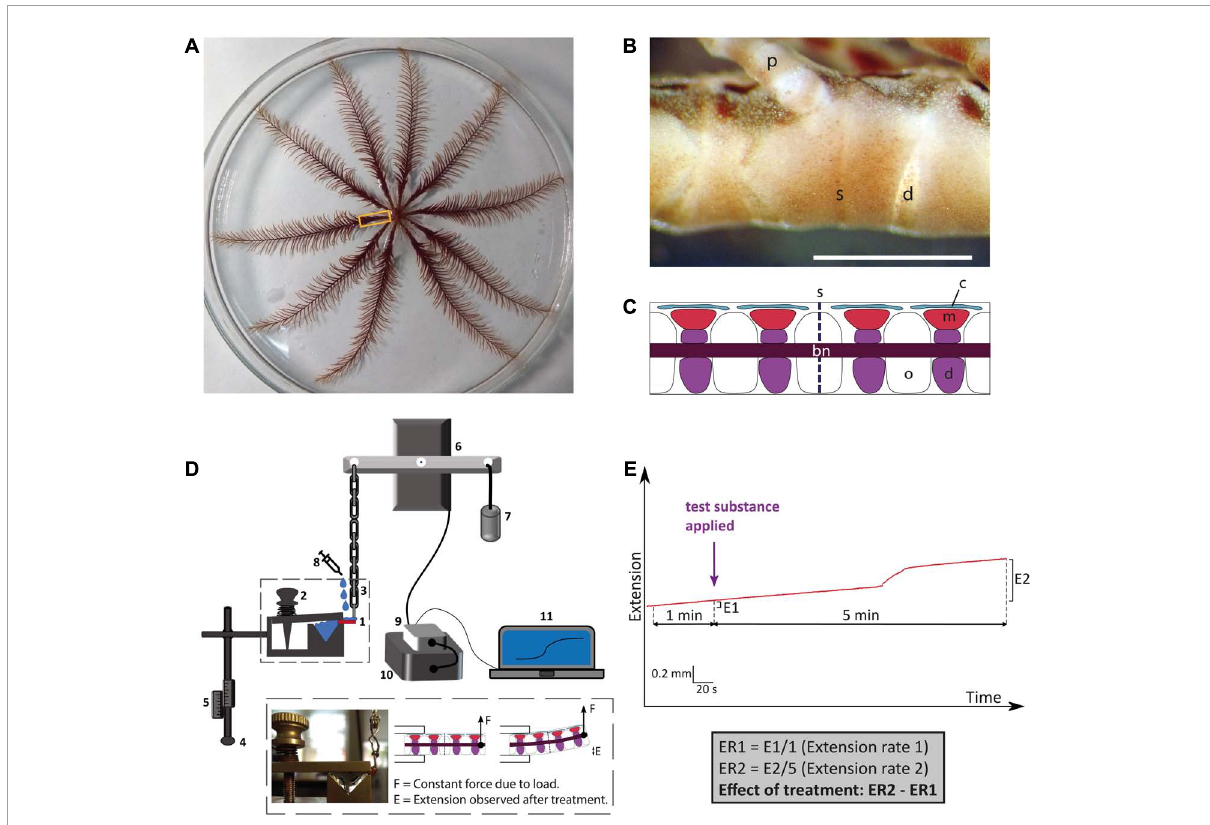
FIGURE1 Anatomy of the whole-body and arms of adult Antedon mediterranea and experimental set-up used to investigate effects of neuropeptides on the mechanical behavior of arm preparations. (A) Photograph of a whole adult specimen of A. mediterranea in an 18 cm diameter petri dish. The rectangle shows the region of an arm nearest to the calyx, which corresponds to the region from which experimental preparations were dissected. (B) Photograph of lateral view of an arm, oral side up and proximal end to the right. The scale bar is 1 mm. d, diarthrosis; s, syzygy; p, pinnule. (C) A schematic drawing of a sagittal section of an arm equivalent to the portion shown in panel (B) . Major anatomical structures are labeled as follows: bn, brachial nerve; c, coelom; d, diarthrosis; m, muscle; o, ossicle; s, syzygy. (D) Schematic drawing of the experimental set-up for testing the effects of neuropeptides on the mechanical properties of arm preparations. The arm preparation (1) is orientated with its oral side up, as is the natural position of the arm, and is clasped at its proximal end by a spring-loaded clamp (2) and connected at its distal end via a heart clip to a chain (3). The exact positioning of the arm preparation in relation to the apparatus can be regulated by a system of rods that are adjusted using clamp manipulators (4) and scales (5). The chain is connected to an isotonic lever transducer (6) and at the opposite end of the lever is a weight of 10 g (7), which creates a tension in the arm preparation similar to that in an arm outstretched for food collection in the animal’s natural environment (La Touche, 1978; Byrne and Fontaine, 1981). Test substances (e.g., neuropeptides) are administered to the preparation using a syringe (8). Changes in the mechanical behavior of the arm preparation are detected by the transducer and relayed via a bridge amplifier (9) to acquisition hardware (10) and then finally to a computer (11), where recordings are made and stored using LabChart software. The inset shows a close-up of an arm preparation positioned in the apparatus and a schematic representation of arm extension after application of a test substance. (E) Schematic representation of the method used to quantify effects of test substances on arm extension. The basal rate of extension is measured during the 1 min prior to application of the test substance (E1). After application of the test substance, recording is continued for a period of 5 min and the extension observed in this testing period is E2. The average extension rates (ER: mm min − 1